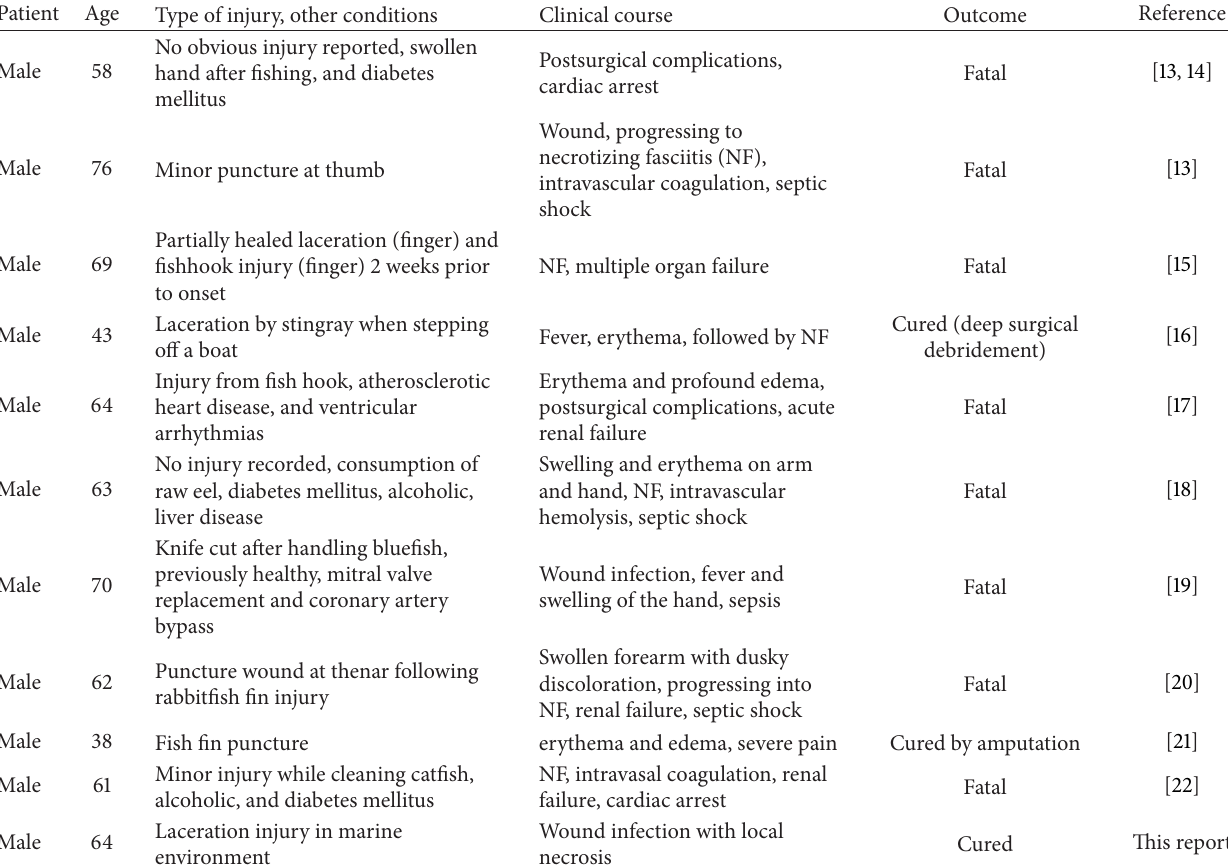
Table 3: Review of the available human cases of severe wound infections ∗ , caused by P. damselae (for other synonyms found in the literature refer to the discussion